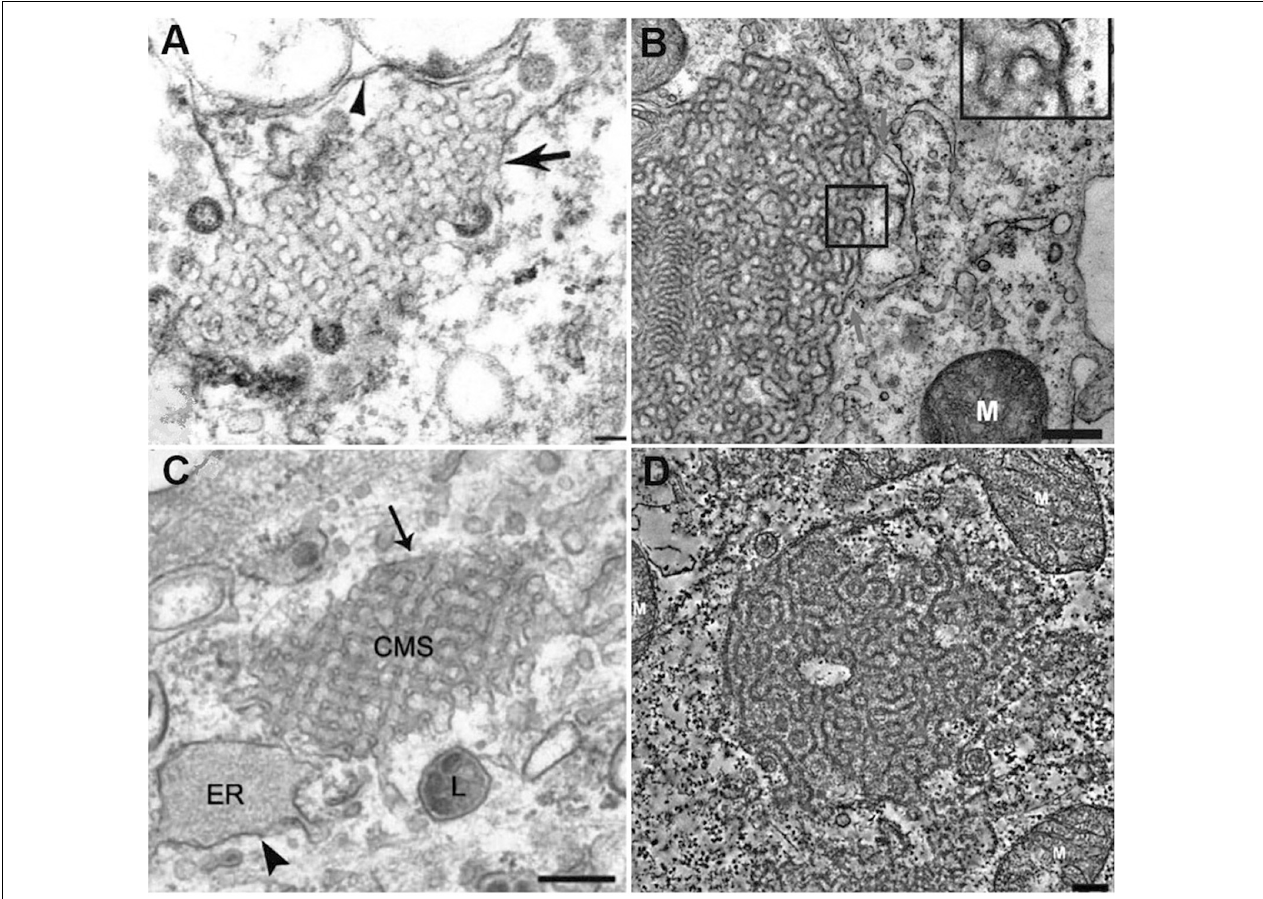
FIGURE 5 | Multiple examples of coronavirus-induced cubic membrane (CM) formation in the host cells. (A) SARS-CoV, 3d post-infection (p.i.) Vero-E6 cell with virus particles egress (Goldsmith et al., 2004) (B) MERS-CoV nsp3-6, 24h post-transfection, Huh-7 cell (Oudshoorn et al., 2017). (C) MHV-59, 8h